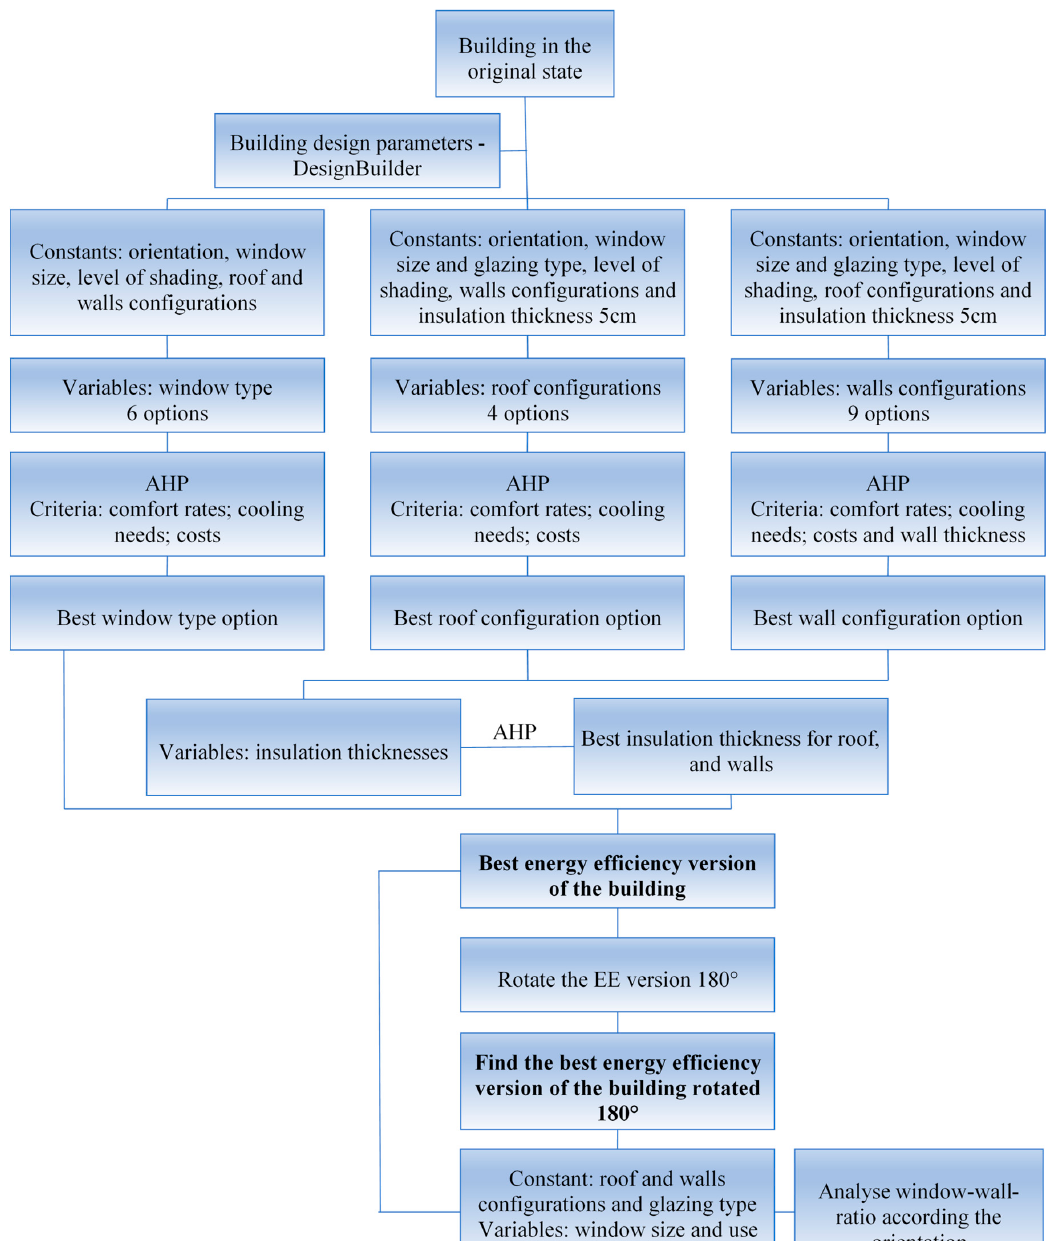
Figure 1. Methodology of the Figure 1 . Methodology of the work.